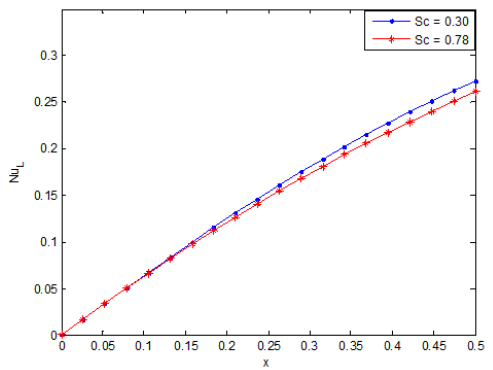
Figure 26. Effects of Schmidt number on Nusselt number